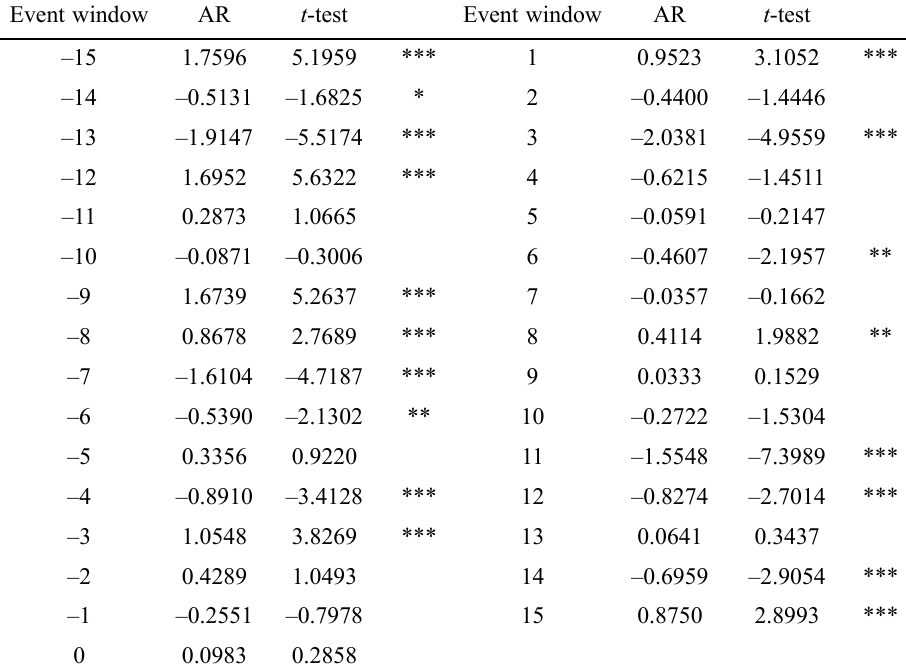
Table 1. AR of biotechnology industry during the period of infectious diseases Event